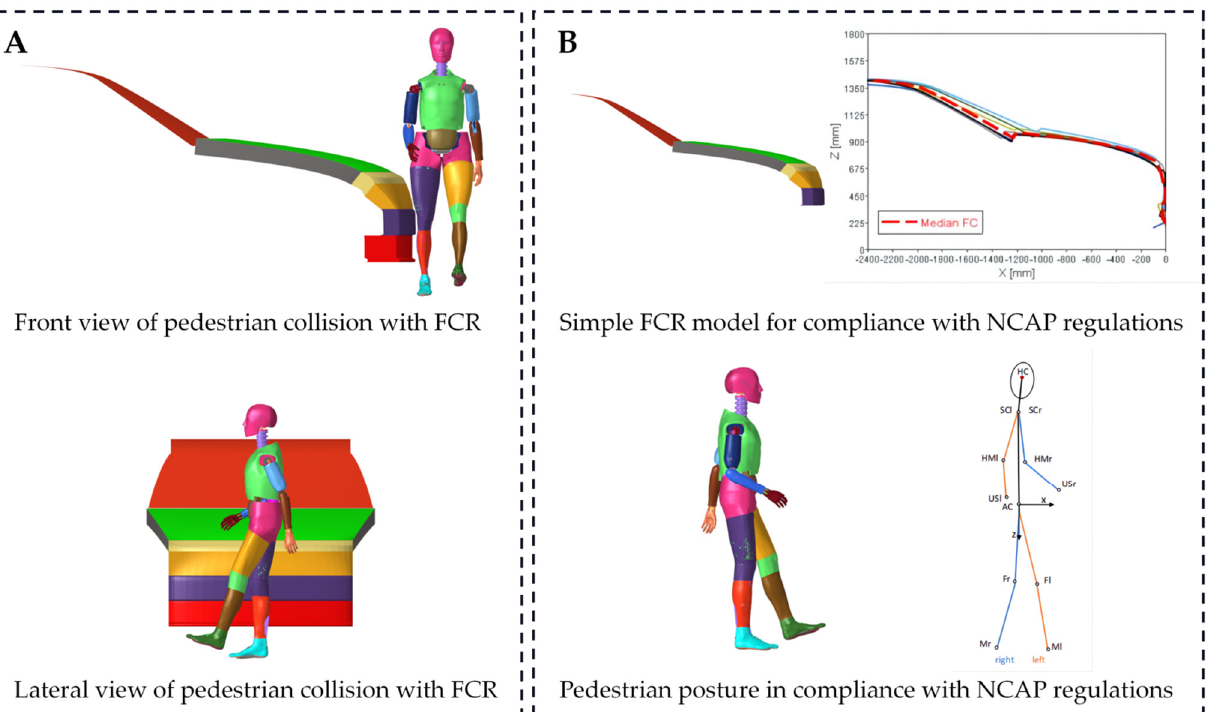
Figure 3. Establishment of FE pedestrian-FCR collision model. ( A ) Two perspectives of pedestrian-FCR. ( B ) FCR and pedestrian standing posture are established and adjusted according to regulatory standards.